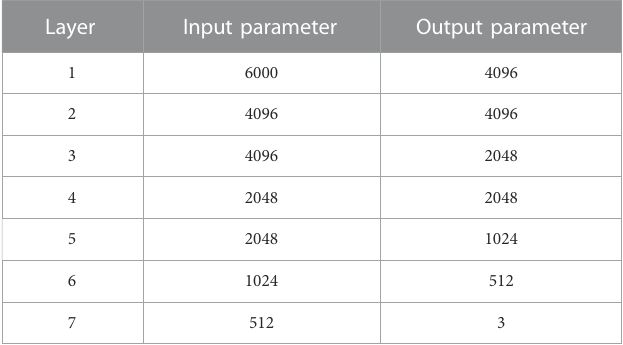
TABLE 2 SAE network parameters.